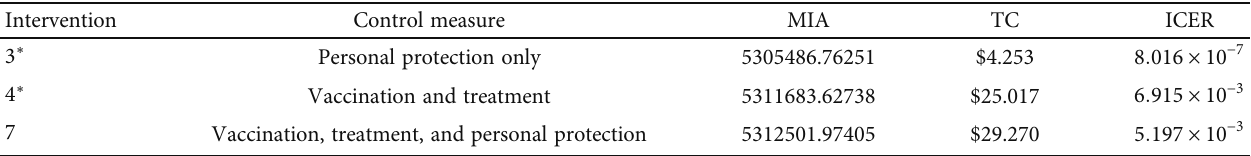
Table 10: Comparing ICER I 3 with I 4